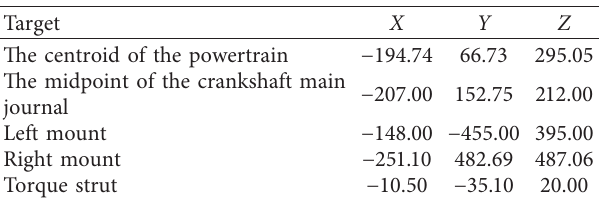
Table 3: The installation position of each mount, powertrain center of mass, and midpoint of crankshaft spindle neck in the automobile coordinate system